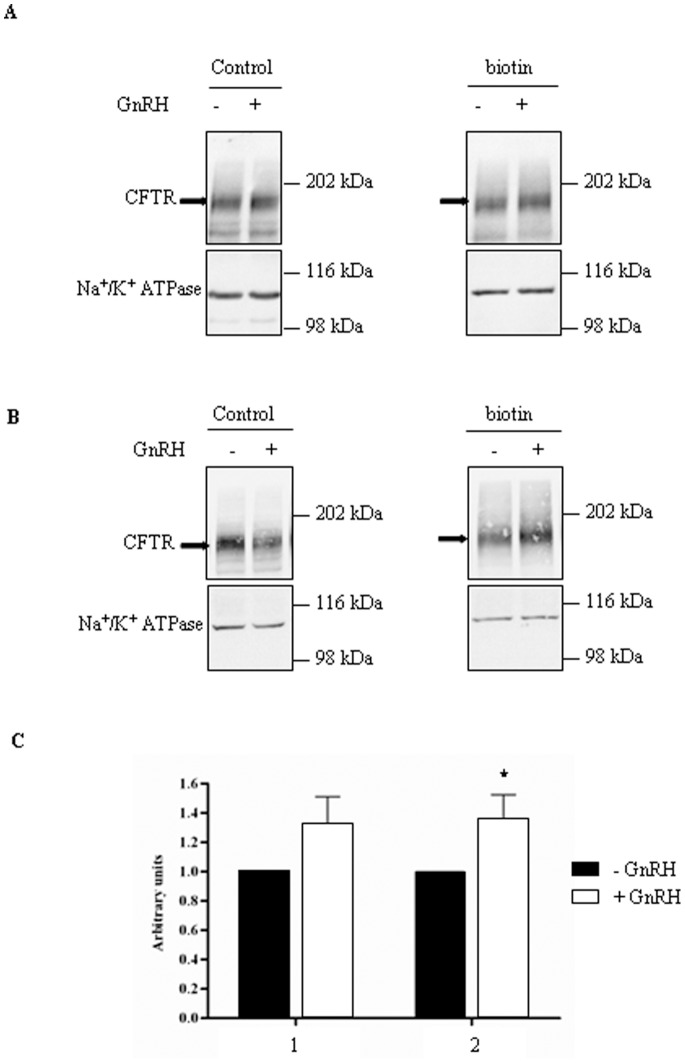
Membrane expression of CFTR after GnRH treatment.The presence of CFTR within membranes was detected by biotinylation experiments. A. Representative immunoblots showing the detection of CFTR in biotinylated surface proteins from 16HBE14o− cells. CFTR is present in total proteins (left) and in biotinylated surface proteins (right) after GnRH treatment (10−9 M) for 60 min. The arrowheads indicate the fully glycosylated (180 kDa) CFTR. B. Same image as in A. with CFBE41o−/corr cells. C. Histograms of the densitometric analysis of CFTR’s cell surface expression (n = 4) in 16HBE14o− (1) and CFBE41o−/corr (2) cells The biotinylated CFTR level is normalized to the biotinylated Na+/K+-ATPase level. Cells incubated with buffer alone are referred as 1 arbitrary unit.